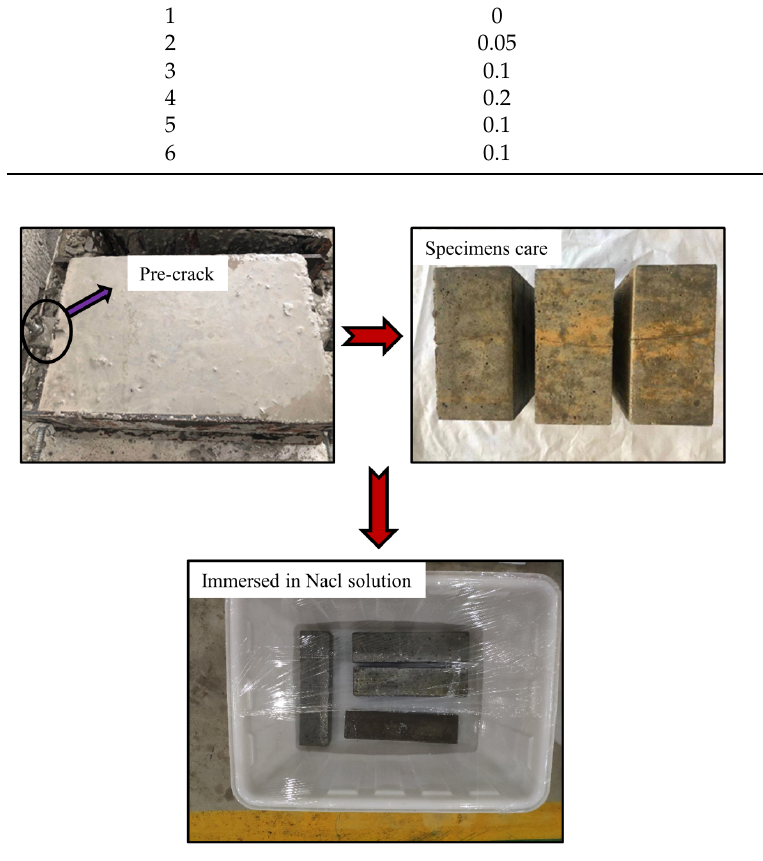
Figure 4. Experimental samples.